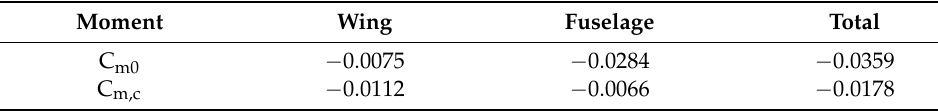
Table 5. The pitching moment of each